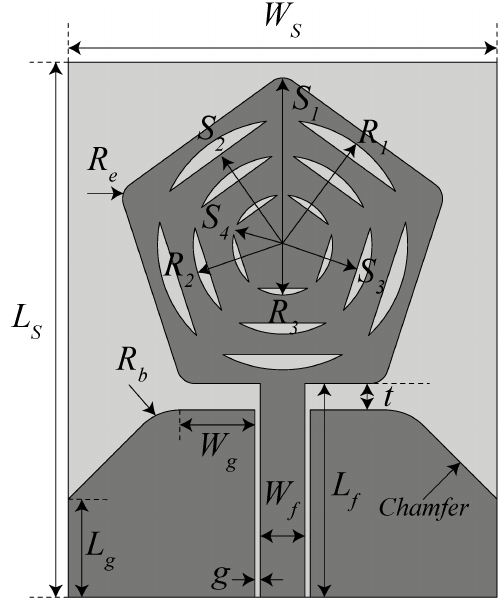
Figure 2. Geometry of the proposed CPW-fed pentagonal fractal antenna.